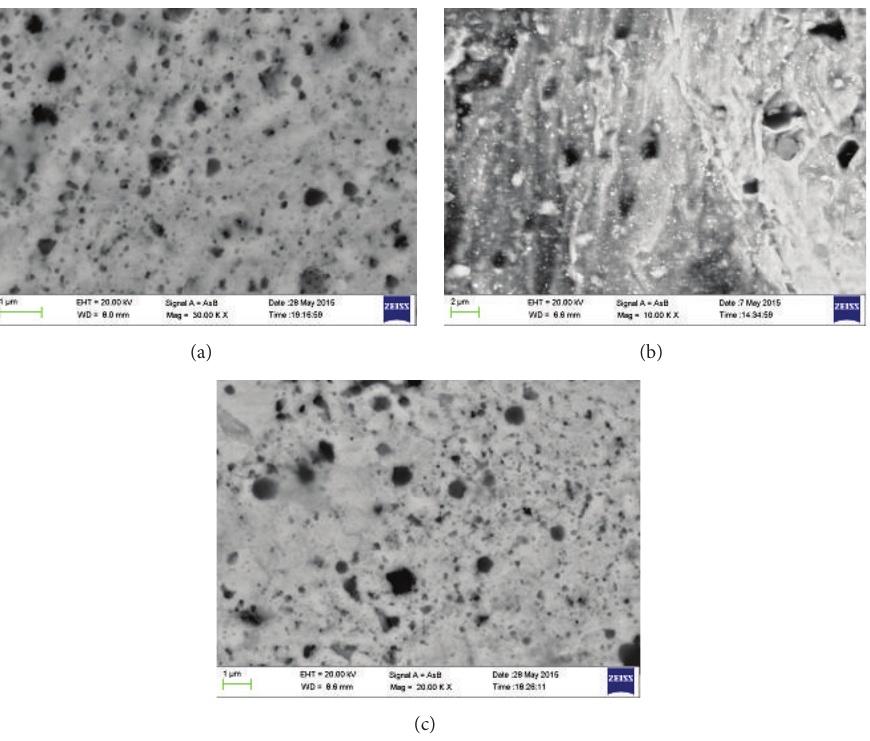
Figure 7: FESEM images of nanocomposites at different parameters: (a) 500 rpm/35 mm/min/2 ∘ , (b) 750 rpm/50mm/min/2 ∘ , and (c) 1000 rpm/20mm/min/1 ∘